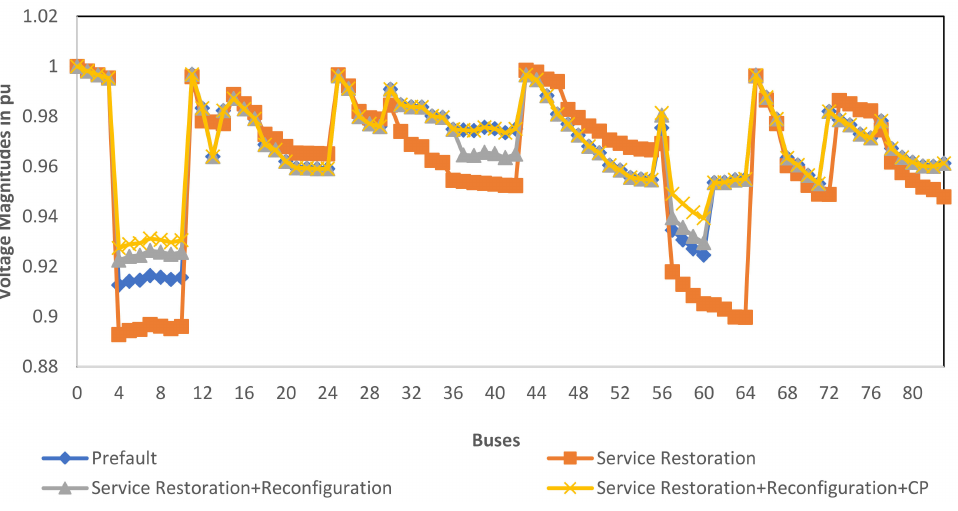
Figure 12. Bus voltage of test case 2 under SFC at zone 2.